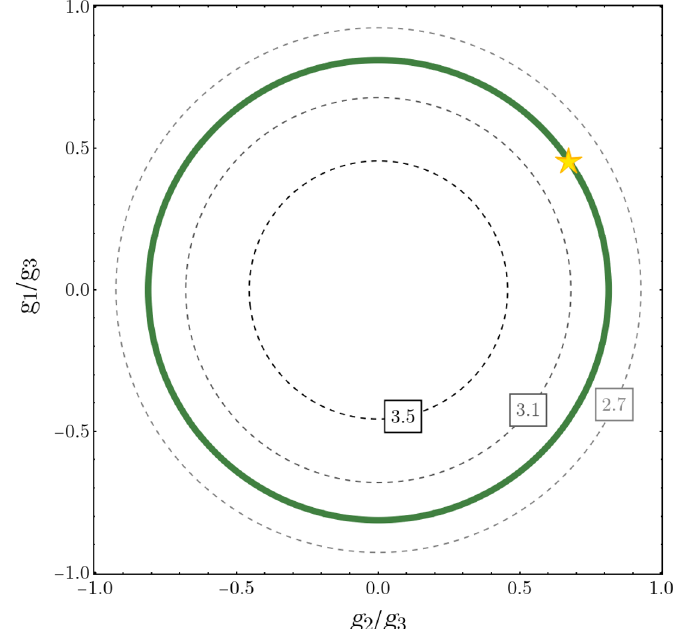
Figure 4. Values of the neutrino Yukawa couplings of the S 0 eq. (4.6) is applicable, allow to reproduce the ratio r at 1 σ (green). Contours refer to a Barbieri- Giudice measure of fine-tuning (see text). The yellow star shows the location of the best-fit point for this